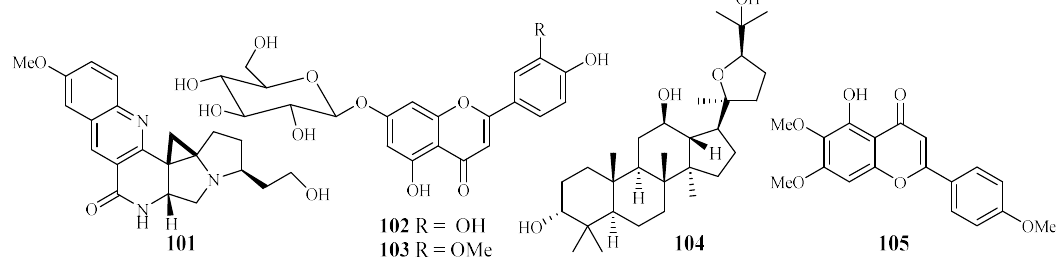
Figure 20. Compounds from Lamiaceae plants.